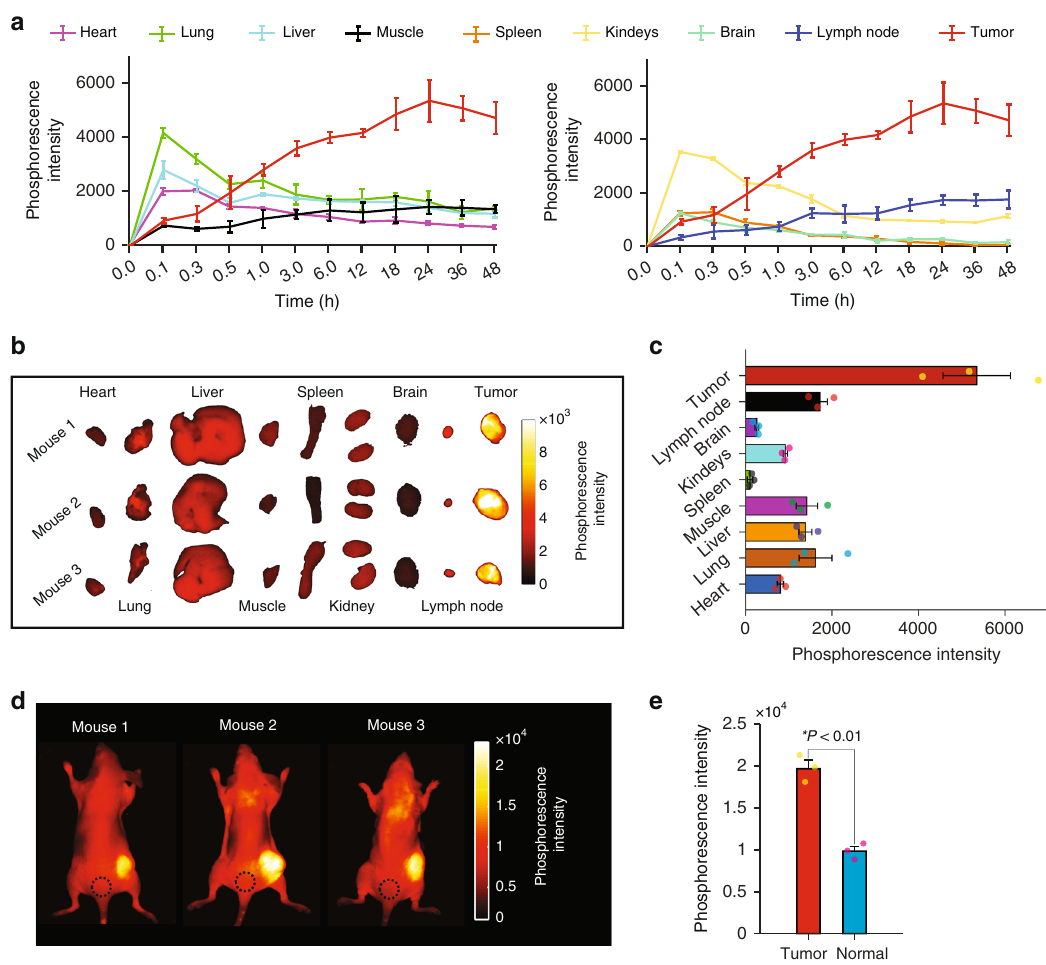
Fig. 1 Bio-distribution of Oxyphor PtG4 measured with IVIS instrument at different time points. a Phosphorescence from different organs and tumors ( n = 3) measured at 12 time points after IV injection of Oxyphor PtG4 ( n = 3 mice per time point, n = 36 mice total). Ex vivo images of the phosphorescence from the excised organs ( b ) and their integrated intensities ( c ) at the 24h time point after IV injection of Oxyphor PtG4 ( n = 3). In vivo images of the phosphorescence ( d ) and the phosphorescence intensities in the tumors and regions of the normal tissue (marked by a black-dashed circle) ( e ) at 24h after injection of Oxyphor PtG4. The mean signal from the tumors (1.97±0.16×10 4 counts, mean±SE) was twice as high as that from the normal tissue (0.98±0.09×10 4 counts, mean±SE) ( n = 3). Error bars represent standard error of the mean. Signi fi cant difference was analyzed by two-sample t